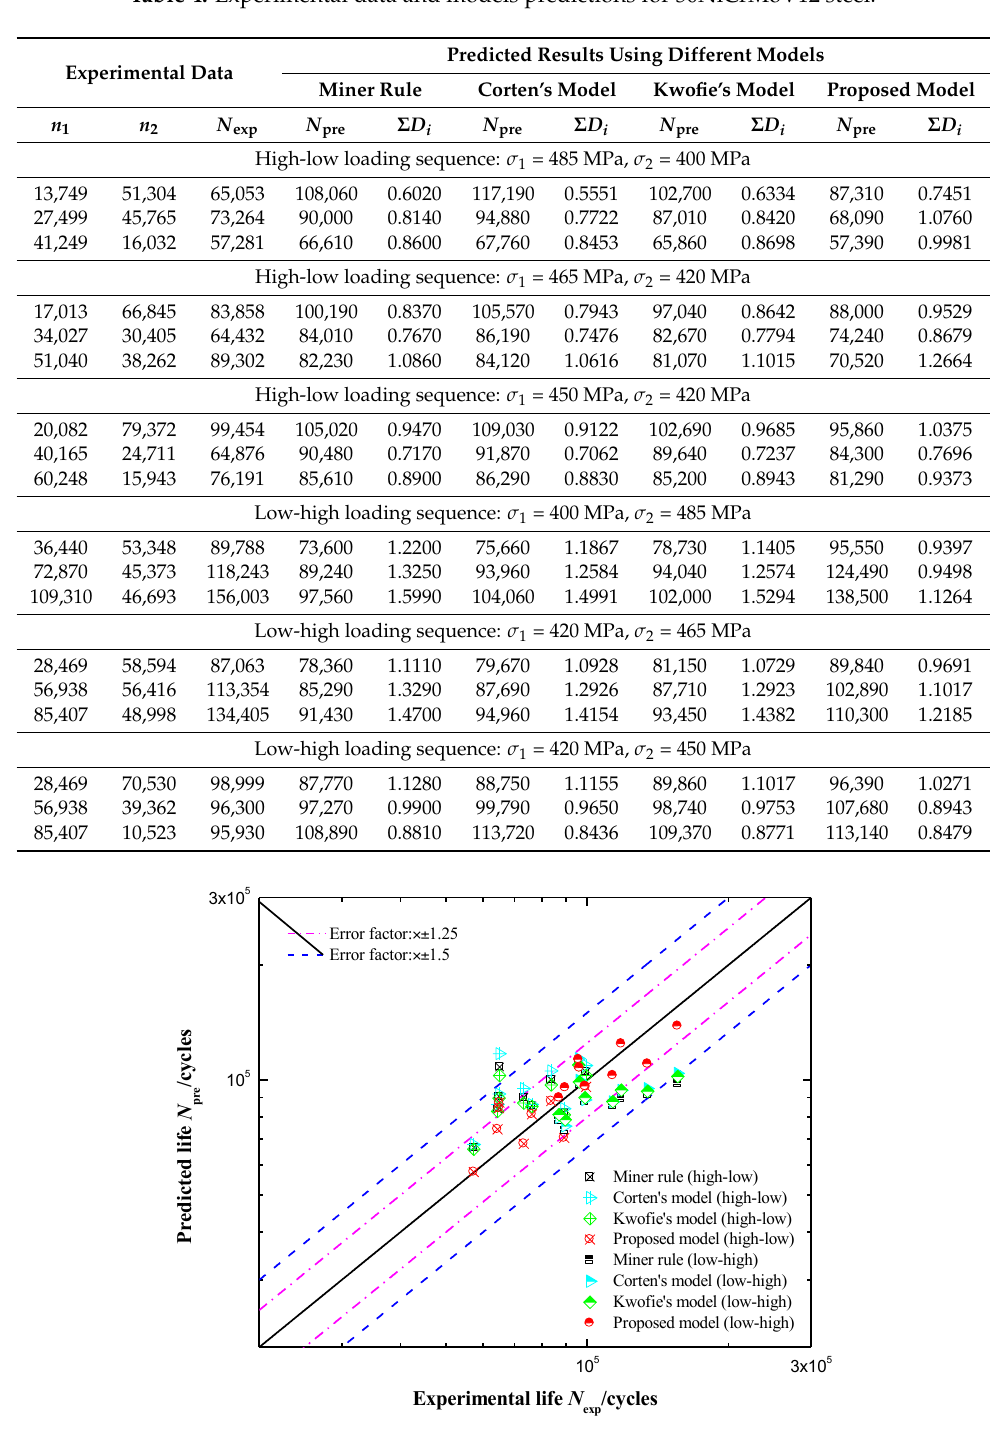
Figure 5. Comparison between the experimental lives and the predicted lives by Miner rule, Corten’s model, Kwofie’s model, and the proposed model for 30NiCrMoV12 steel.